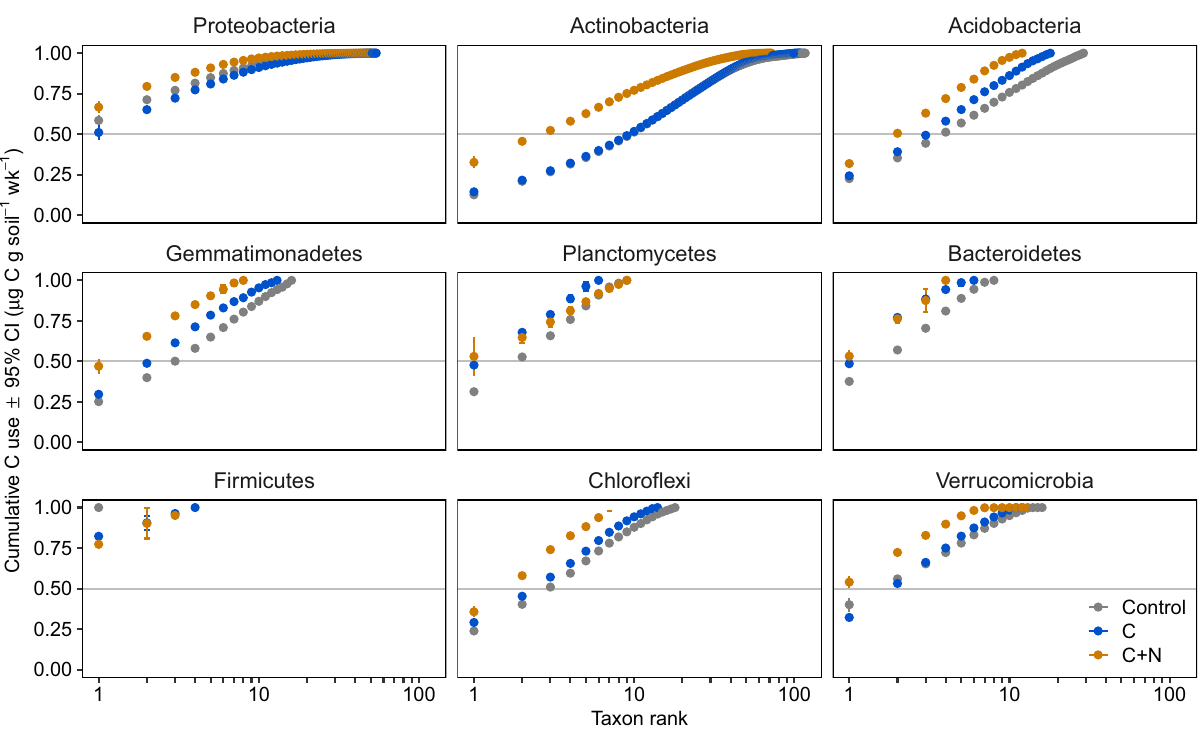
Fig. 6 Change in functional evenness across soil nutrient amendments and major bacterial phyla. Cumulative contribution of bacteria to total relativized carbon (C) use (the sum of μ g C – CO 2 respired and μ g MBC produced per taxon relativized by total C use across all taxa, both per g dry soil per week [wk]) across soil amendment. Points represent averages across soil replicates from four ecosystems (mixed conifer forest, ponderosa pine forest, piñon pine- juniper scrubland, and desert grassland) ( n = 3 experimental replicates). Color indicates soil treatment (Control = no amendment, C = carbon — glucose — only, C + N = carbon and nitrogen — [NH 4 ] 2 SO 4 ). Taxa were ranked by individual contribution to C